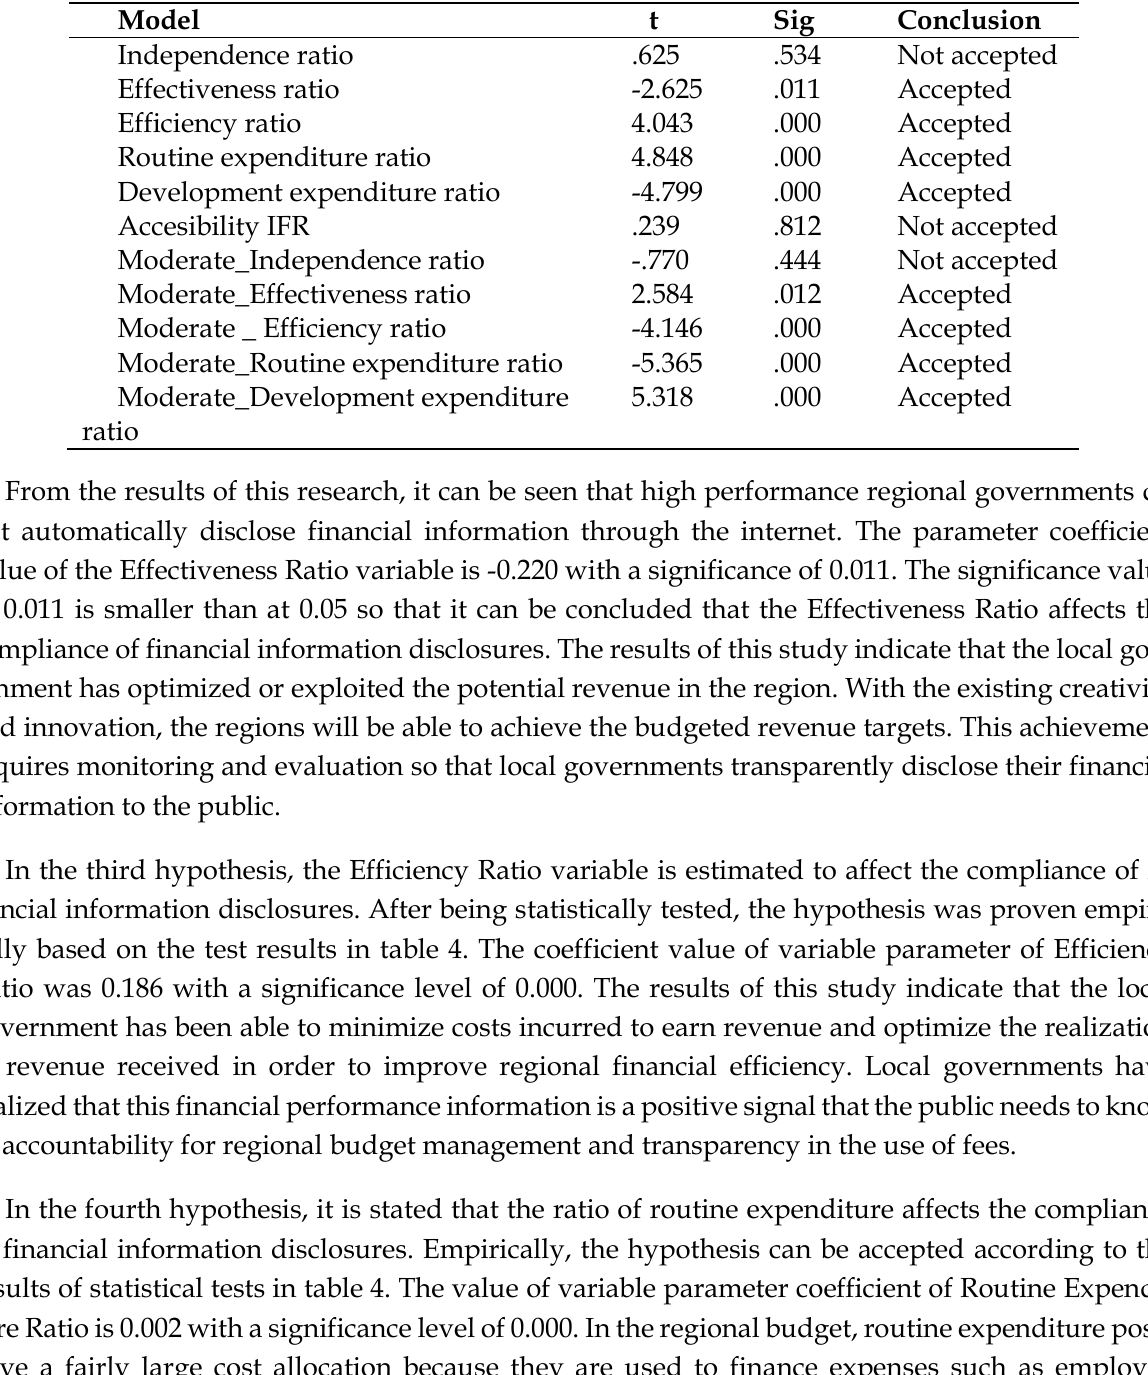
Table 5. Result of Hypothesis